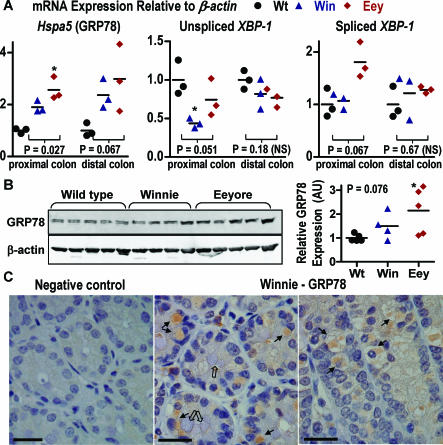
Evidence of ER Stress and UPR Activation in Mice with Muc2 Mutations(A) mRNA expression of hspa5 (GRP78) and the unspliced and spliced forms of Xbp-1 in the proximal and distal colon of wild-type C57BL/6 (WT), Winnie (Win), and Eeyore (Eey) mice determined by quantitative PCR and expressed relative to β-actin with the mean ratio for the WT group in each tissue corrected to 1. Statistics: n = 3 individual data points shown, Kruskal-Wallis nonparametric analysis (p-values shown) with Dunn's multiple comparison test (*p < 0.05 versus wild type). NS, not significant.(B) Fluorescence Western blotting was used to determine the expression of GRP78 in the proximal colons of WT, Win, and Eey mice. Blots were simultaneously stained with antibodies reactive with β-actin as a loading control, and densitometry was used to quantify expression of each protein, which was then expressed as a proportion of the mean expression in wild-type mice with the mean ratio of the WT group corrected to 1. Statistics as in (A), n = 5.(C) Transverse crypt section (centre) and a longitudinal crypt section through the vacuole-rich base of goblet cells (right) from Winnie mice showing immunohistochemical detection of GRP78 in vacuolar accumulations (solid arrows) but not in thecae where present (hollow arrows). Lack of staining in the absence of the GRP78 antibody demonstrates specificity (left, negative control). Scale bars = 50 μm.